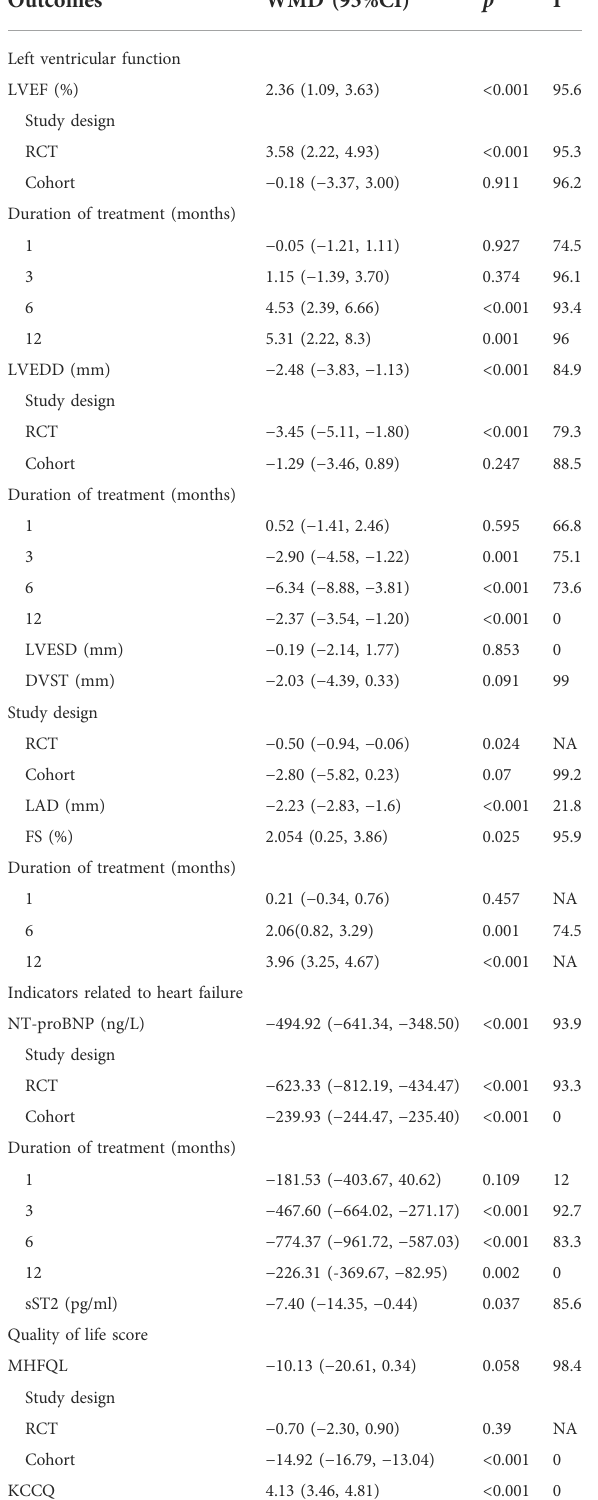
TABLE 3 Ef fi cacy and safety of sacubitril-valsartan treatment in HFmrEF patients.